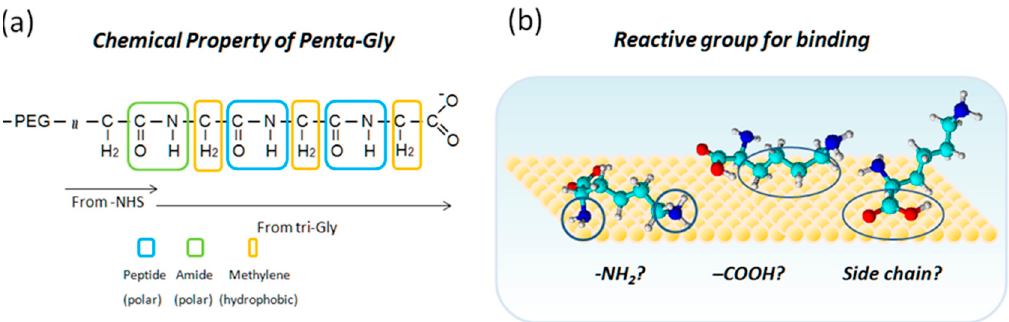
Figure 7. Chemical structure of PEG-tethered penta-Gly. ( a ) Chemical properties of PEG-tethered penta-Gly with an emphasis of length dependent units in boxes in different colors. The amide and peptide groups are similar but the former is formed between amino acids and non-amino acids whereas the latter is between amino acids. Penta-Gly will find polar areas (positively or negatively charged) and/or hydrophobic patches on the pyrite surface for enhanced binding compared with negatively charged monomer Gly, which may occasionally find positively charged sites; and, ( b ) possible factors that may be responsible for the interactions of amino acids with pyrite surfaces.